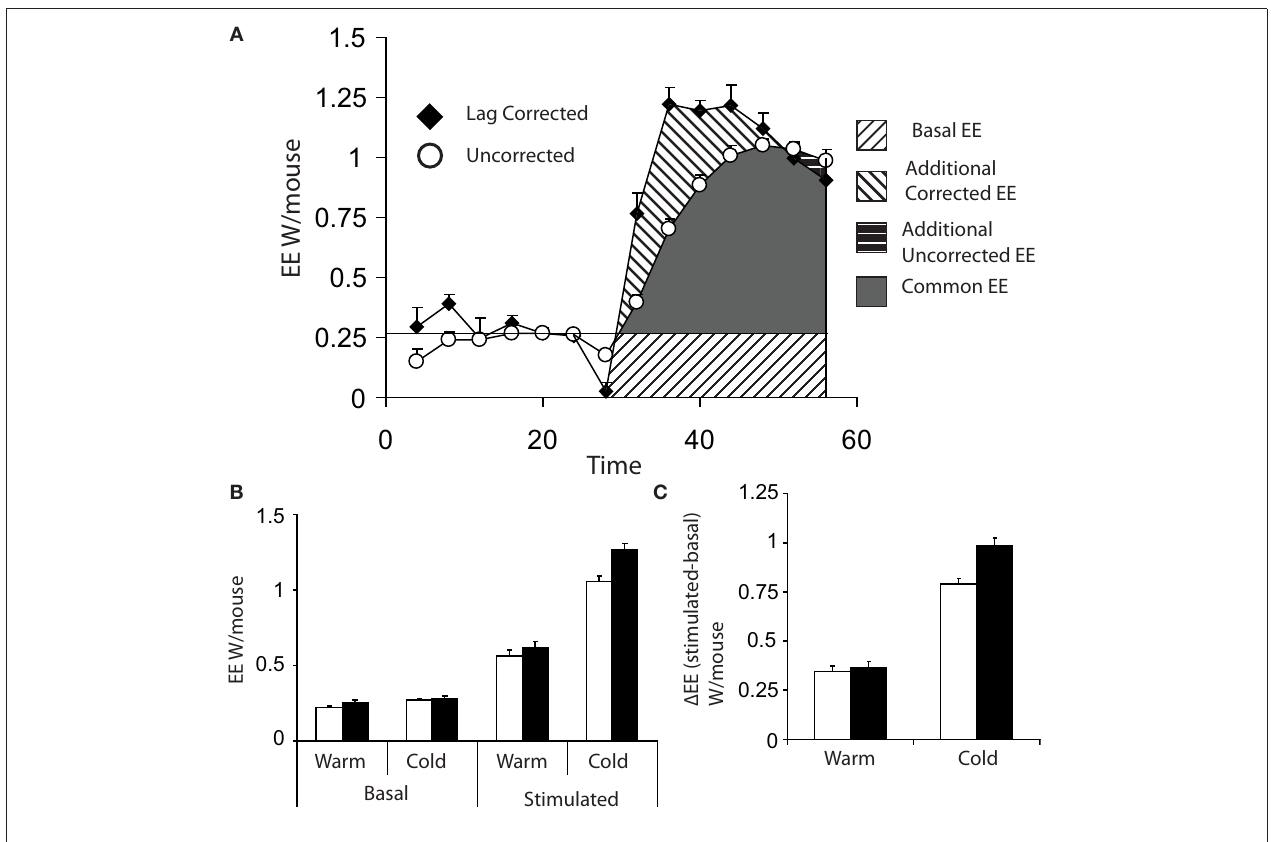
FIGURE 3 | (A) Comparison of energy expenditure plots from Figures 1A,B of 8 cold acclimated mice, which have been corrected for lag (black diamonds) or uncorrected (white circles). (B) Basal (the average of the last three energy expenditure readings prior to injection) and maximum norepinephrine (NE) stimulated energy expenditure (energy expenditure) (average of the largest three recorded values) based on either lag corrected (black bars) or uncorrected (white bars). (C) (cid:2) energy expenditure (maximal